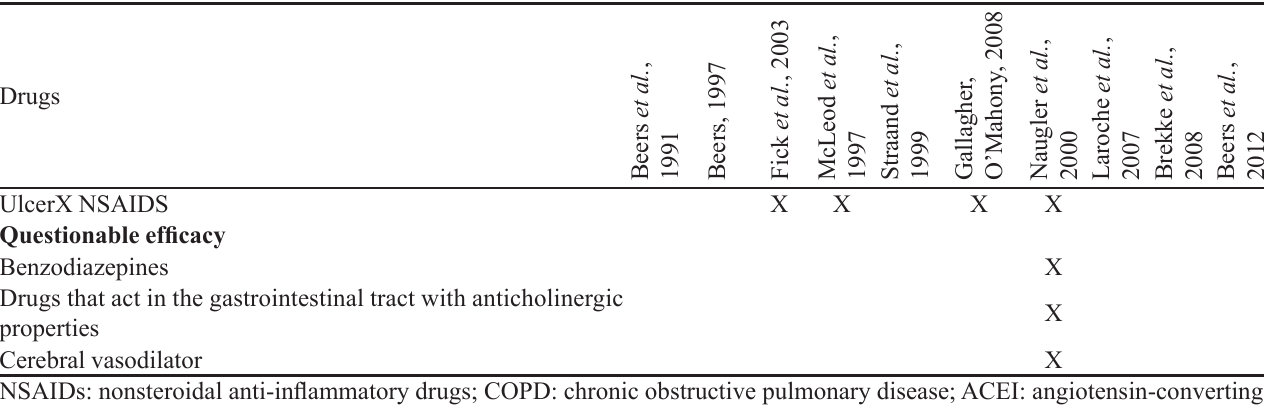
TABLE IV - List of potentially inappropriate medications (PIM) for the elderly that should be avoided as indicated by the clinical diagnosis of the patient (drug interaction with disease), the dose, frequency and duration of the drug administration and drug association, according to the methods identified in PAHO (available at: http://regional.bvsalud.org/php/index.php), Lilacs and Pubmed databases, during the period between February and March 2010 (n=9)